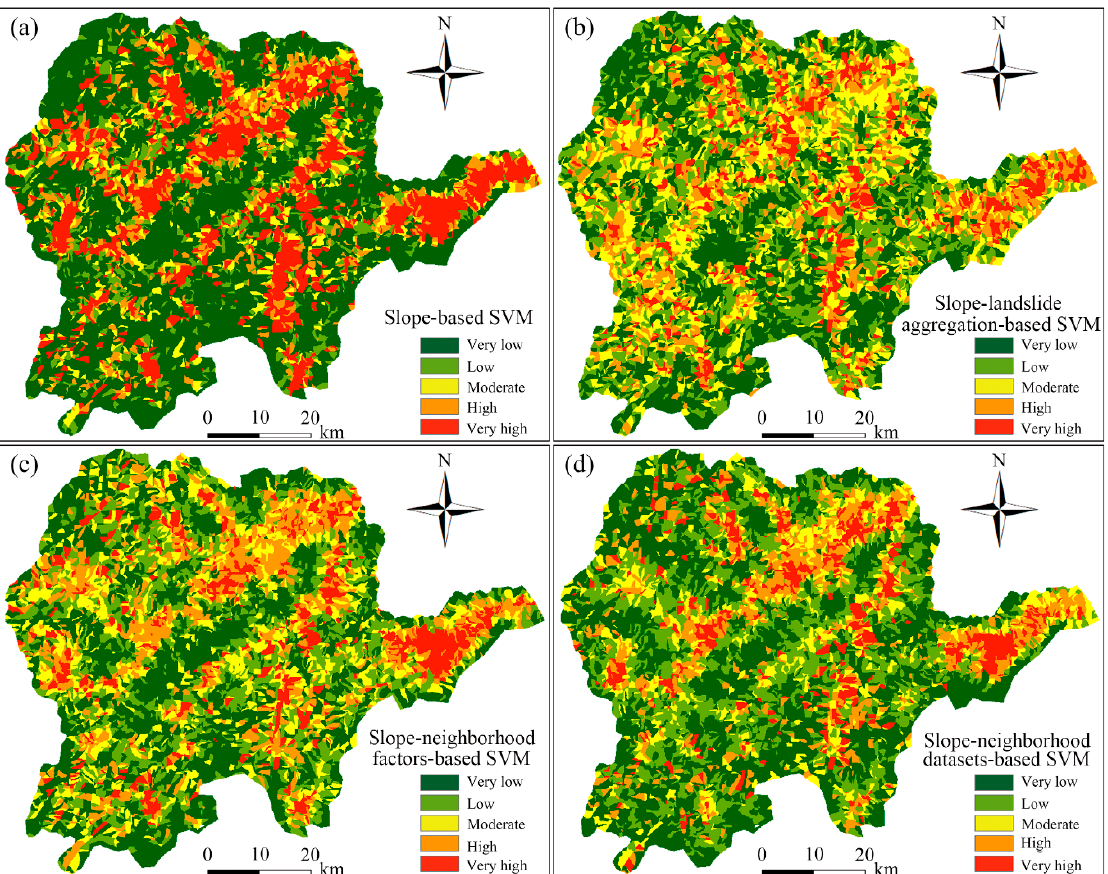
Figure 7. LSP under different combination conditions based on the SVM model. ( a ) Slope-based SVM; ( b ) Slope–landslide aggregation-based SVM; ( c ) Slope–neighborhood factors-based SVM; ( d ) Slope–neighborhood datasets-based SVM.